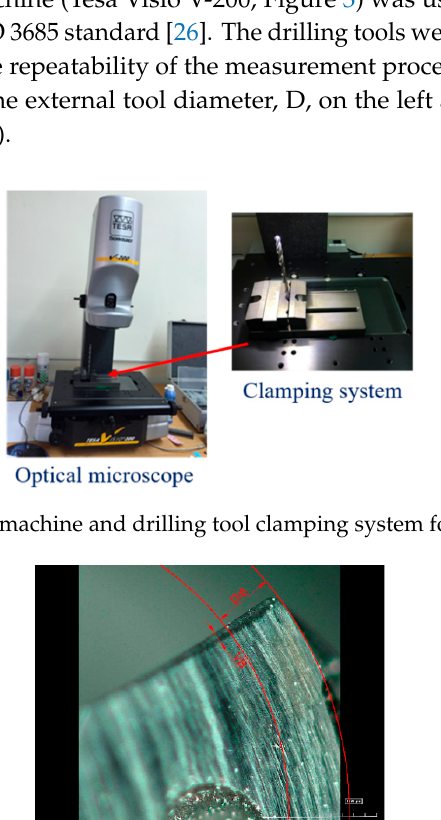
Figure 2. Experimental set-up of CFRP/CFRP stack drilling.